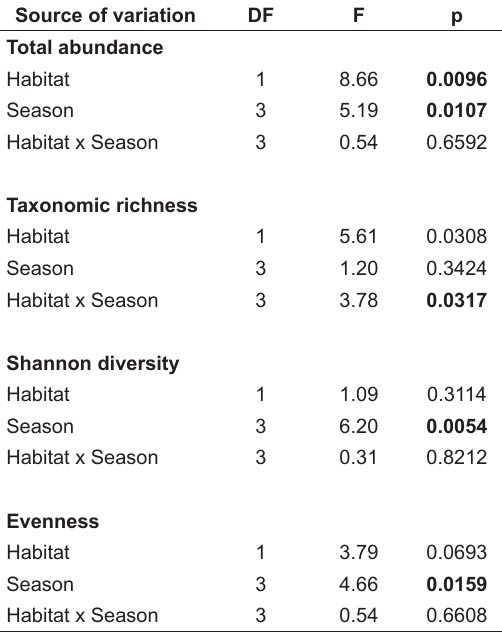
Table 3. Results of ANOVAs showing the effect of habitat type and seasons on macroinvertebrates drift attributes. Significant p values are in